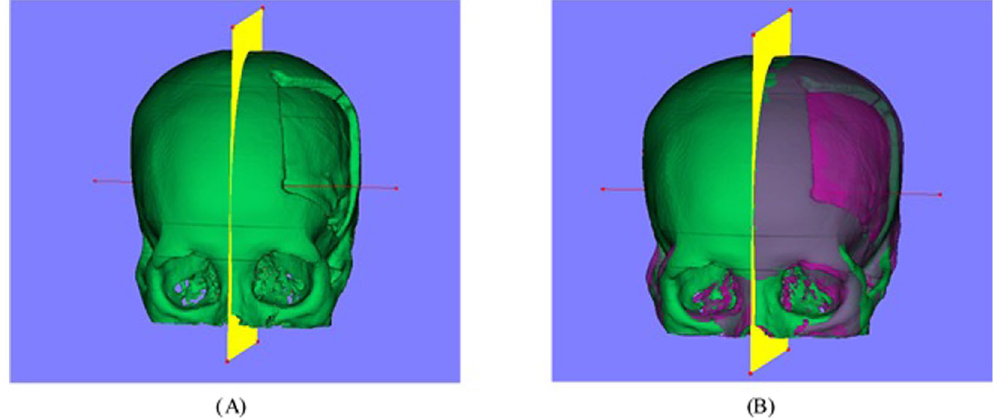
Figure 8. Mirroring model: ( A ) the generated median plane, ( B ) the mirrored model based on the median plan and the cranial model.